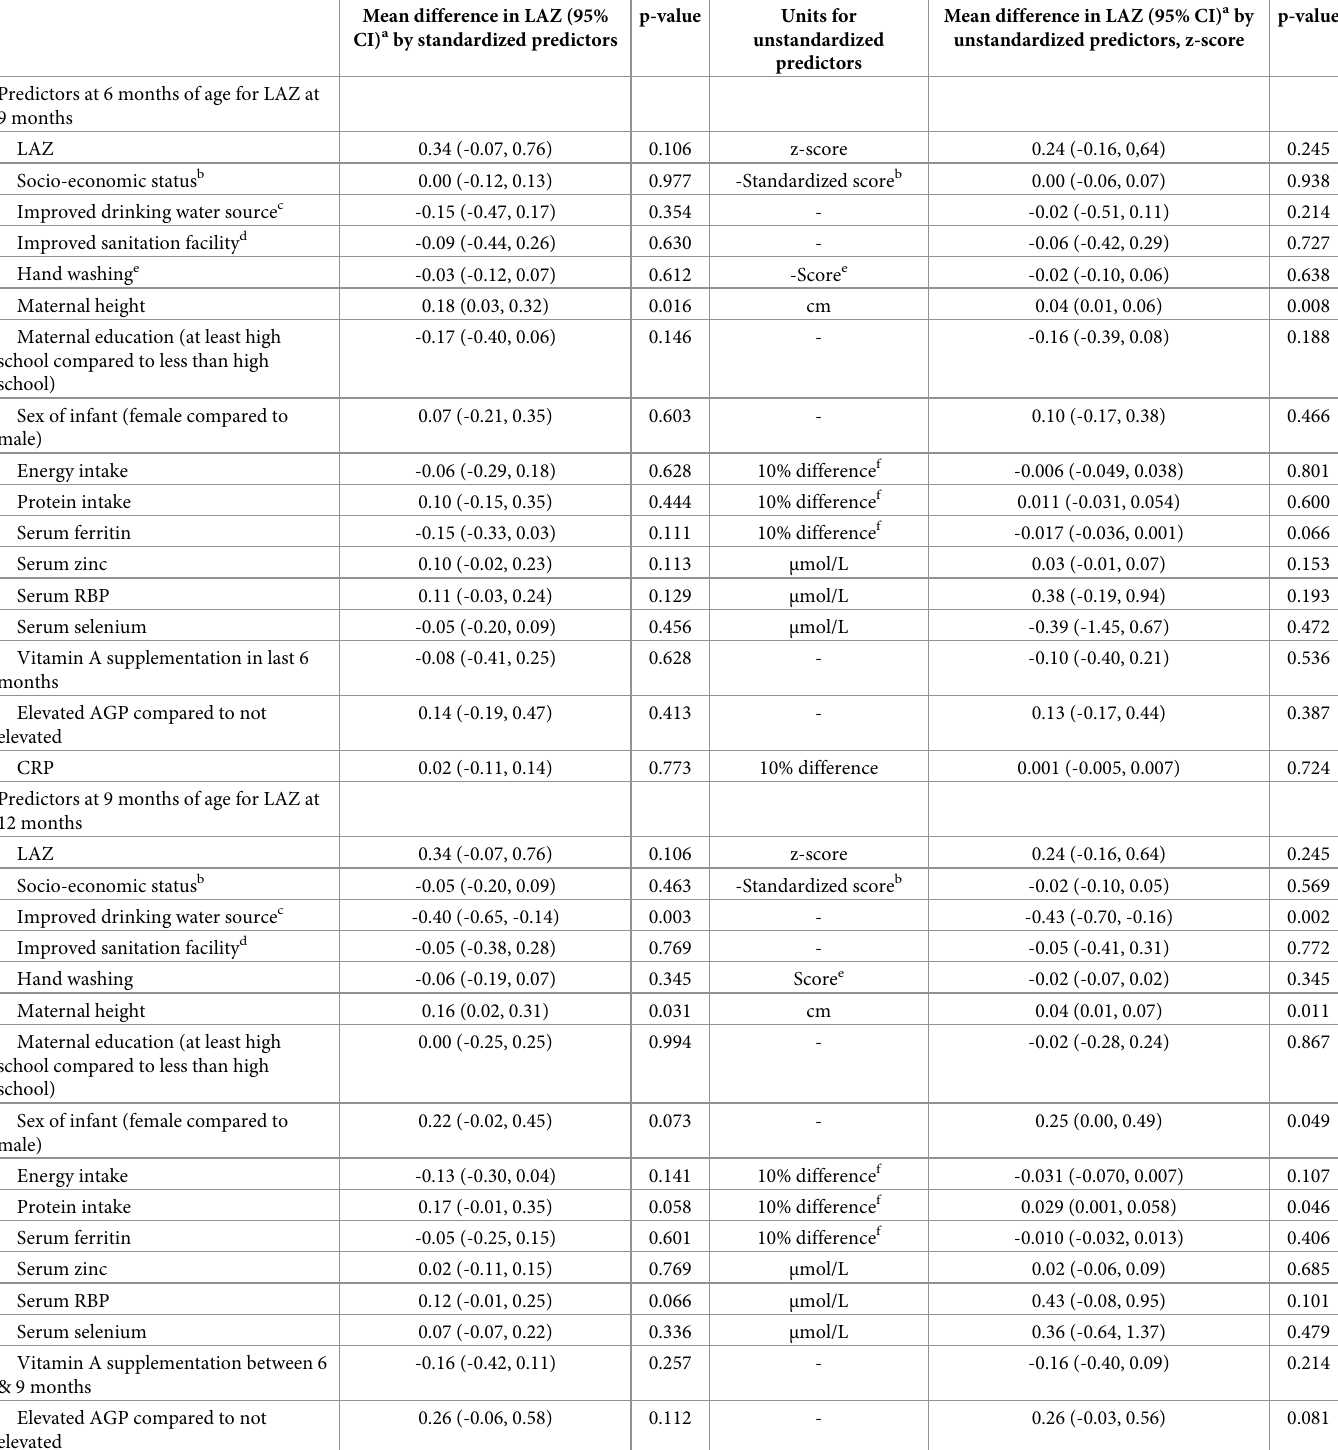
Table 7. Demographic, nutrient, biomarker, and health predictors of length-for-age z-score (LAZ) at 6 and 9 months and 9 and 12 months of age (n =